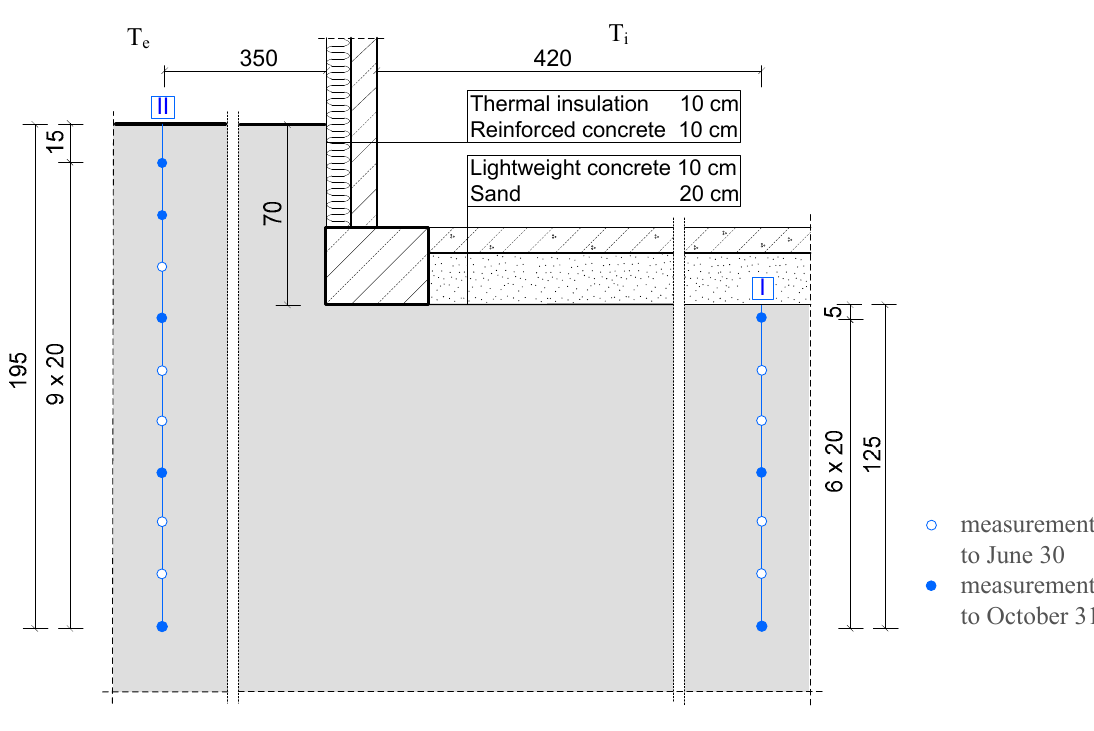
Figure 1. Schematic of the arrangement of temperature sensors. Temperature distribution in the ground was measured using a multi-channel, automatic measurement system. Temperature measurements were made with YSI 44,005 thermistors with a measuring range from − 40 to + 105 ◦ C and a measurement accuracy of 0.5 ◦ C. The